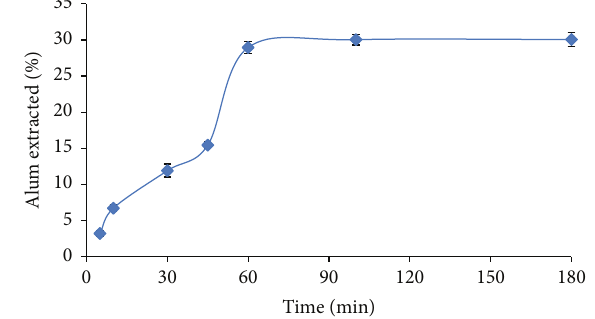
Figure 4: Effect of calcination time on the extraction of aluminum sulphate (particle size: 100 𝜇 m; temperature: 800 ∘ C; error bar = ± SD; and 𝑛 = 3